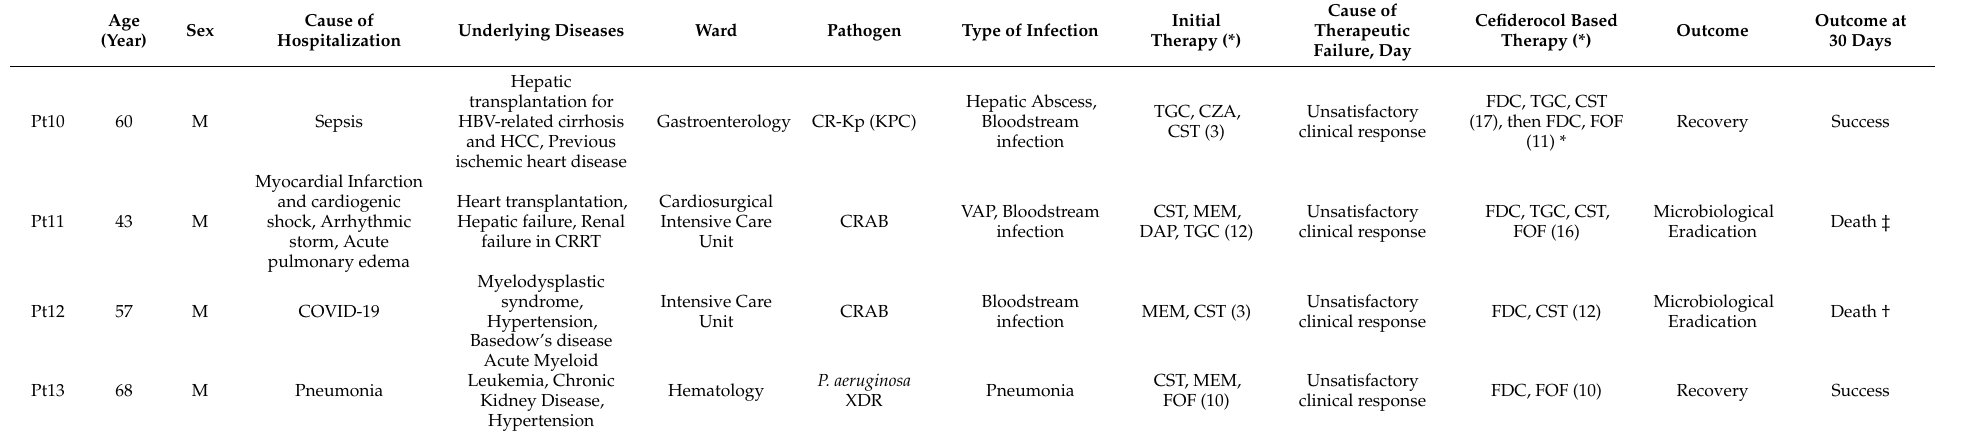
Table 3. Characteristics of patients of Group 3, with immunocompromised